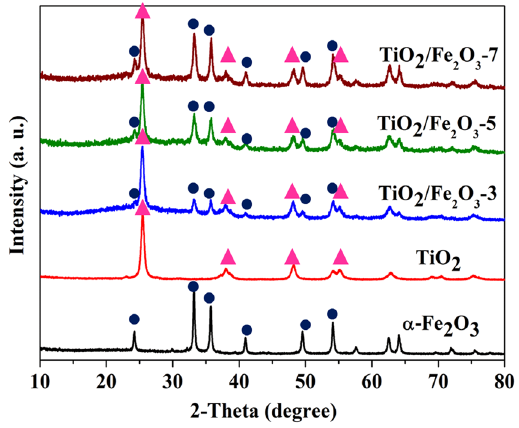
Figure 1. XRD patterns of pure TiO 2 , pure α -Fe 2 O 3 and TiO 2 /Fe 2 O 3